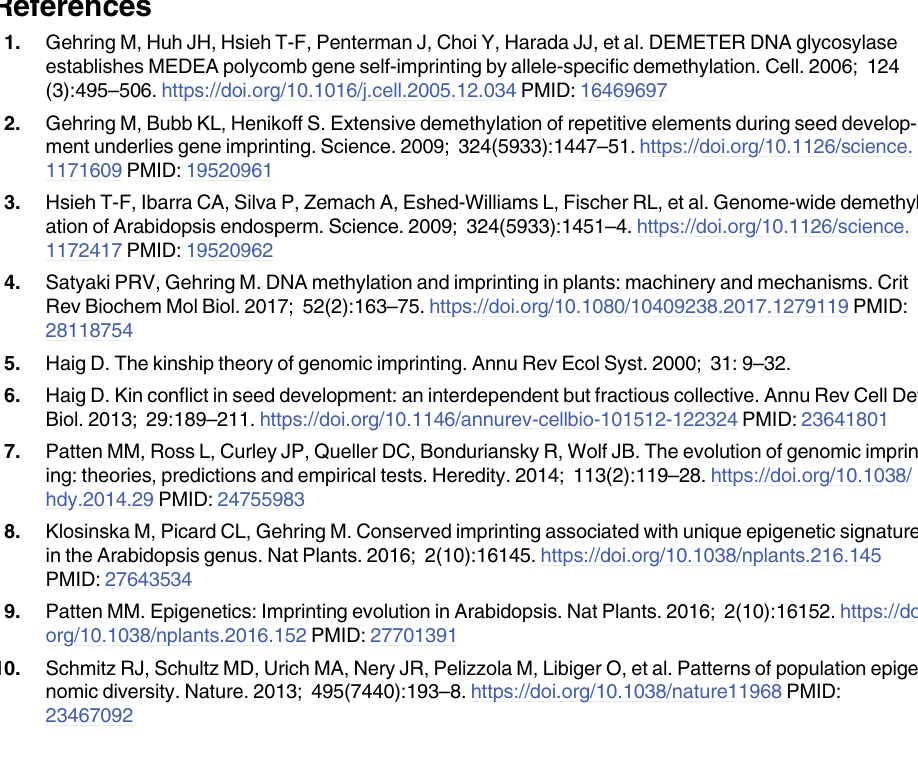
S3 Table. Tests for statistical significance for pairwise comparisons of differences in endo- sperm or embryo development. S4 Table. Gene expression differences in hdg3-1 endosperm vs. Col endosperm at 7 DAP determined using CuffDiff. S5 Table. Oligos used in this